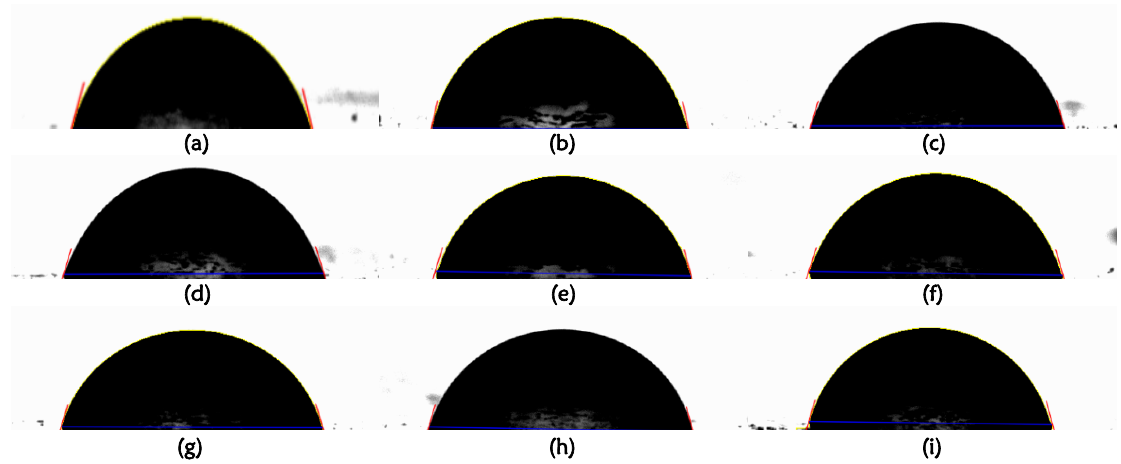
Figure 1: Micrograph images of water dropping on nanocoating: (a) Plain Epoxy; (b) 2wt% ZnO; (c) 3wt% ZnO; (d) 2wt% SiO 2 ; (e) 3wt% SiO 2 ; (f) 1wt% ZnO+4wt% SiO 2 ; (g) 2wt% ZnO+3wt% SiO 2 ; (h) 3wt% ZnO+2wt% SiO 2 ; (i) 4wt% ZnO+1wt% SiO